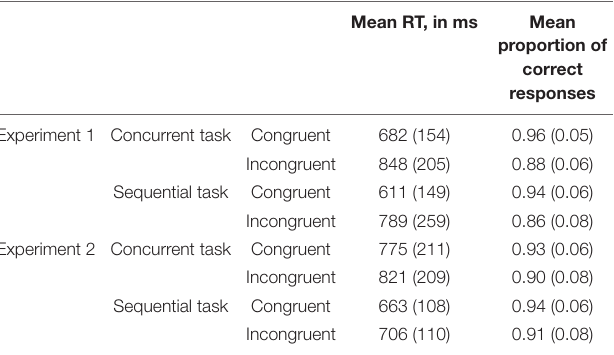
TABLE 1 | Mean RT and accuracy data for the Stroop task (with standard deviations in parentheses) for congruent and incongruent trials in Experiment 1 (high proportion congruent) and Experiment 2 (low proportion